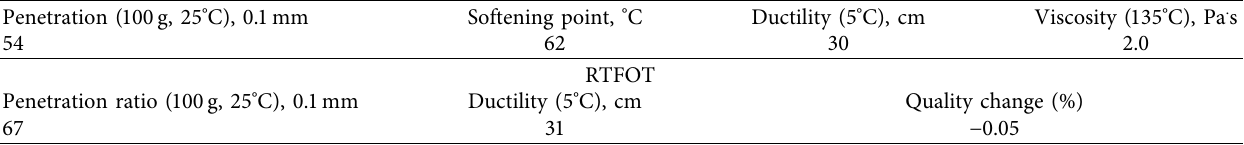
Table 2: Property of SBS-modified asphalt.